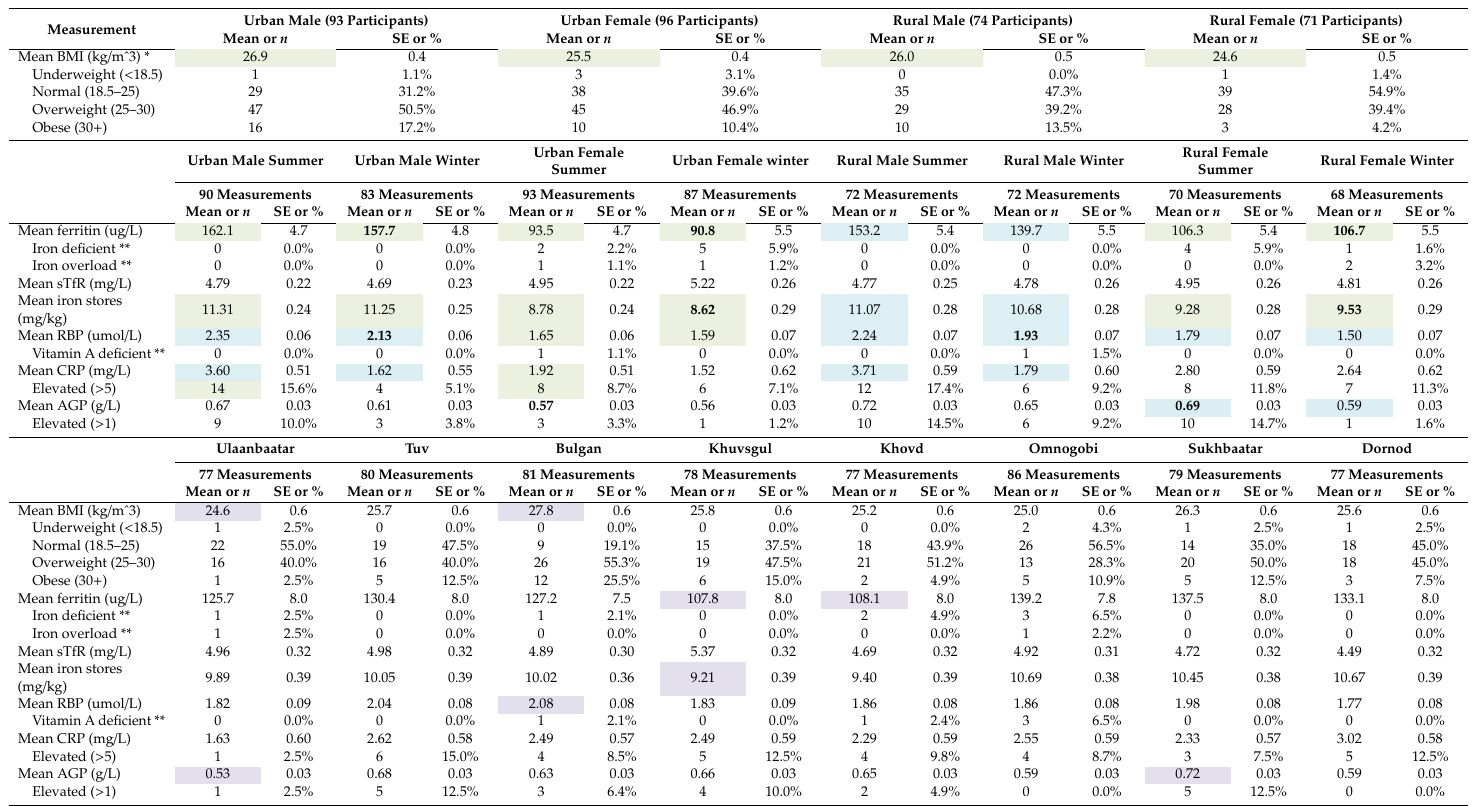
Table 4. Mean body mass index and serum biomarker concentrations by subgroup, subgroup-season, and province.